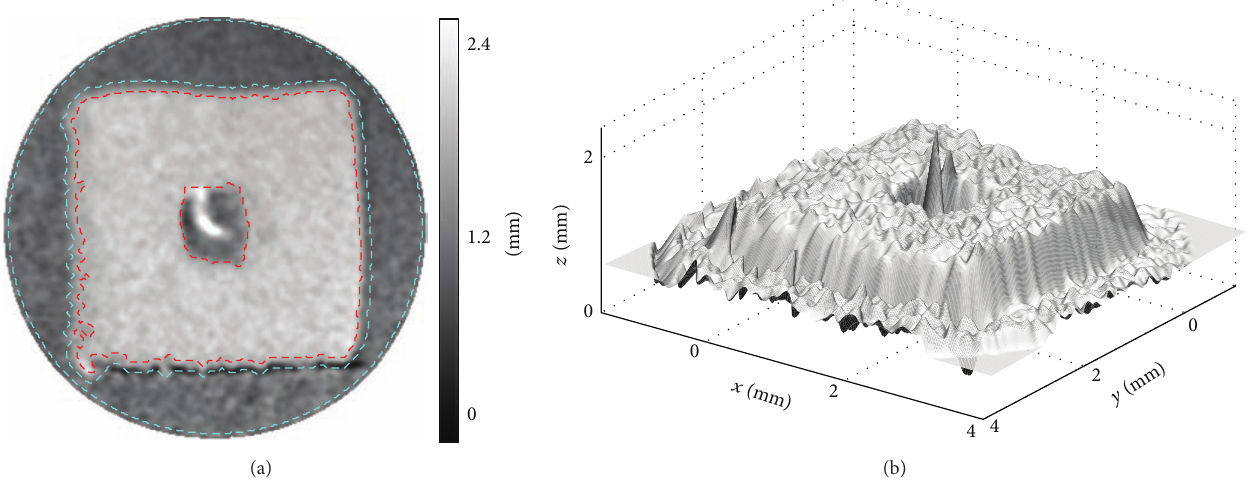
Figure 14: Underwater experiment. (a) Surface height map in 2D and (b) surface profile in 3D of the MEMS